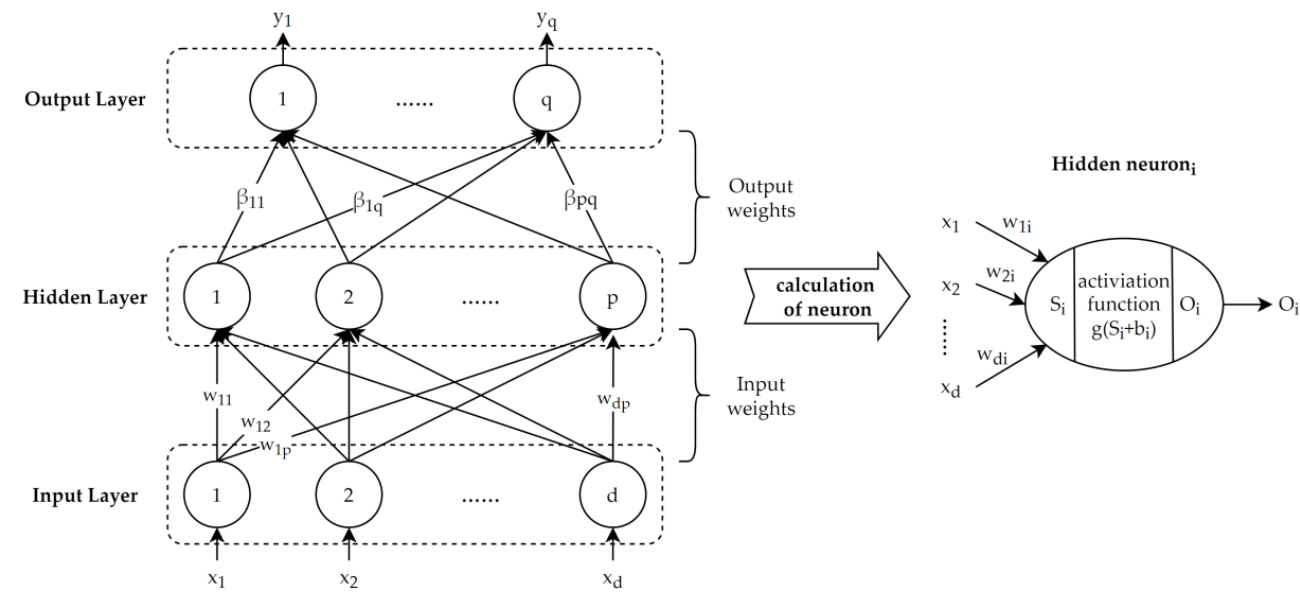
Figure 2. The schematic diagram of ELM.